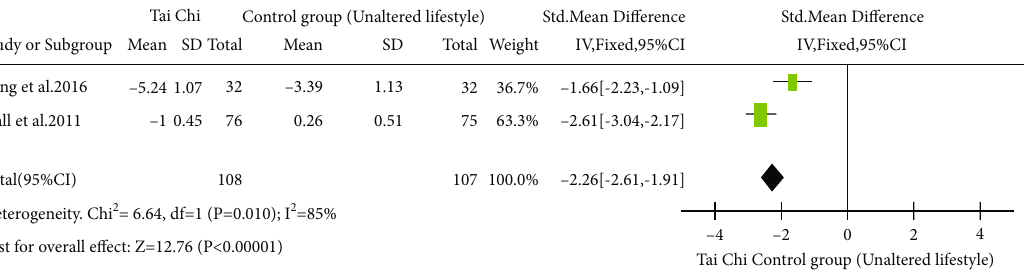
Figure 6: Forest plot of subgroup analysis of Tai Chi vs. control group (unaltered lifestyle).